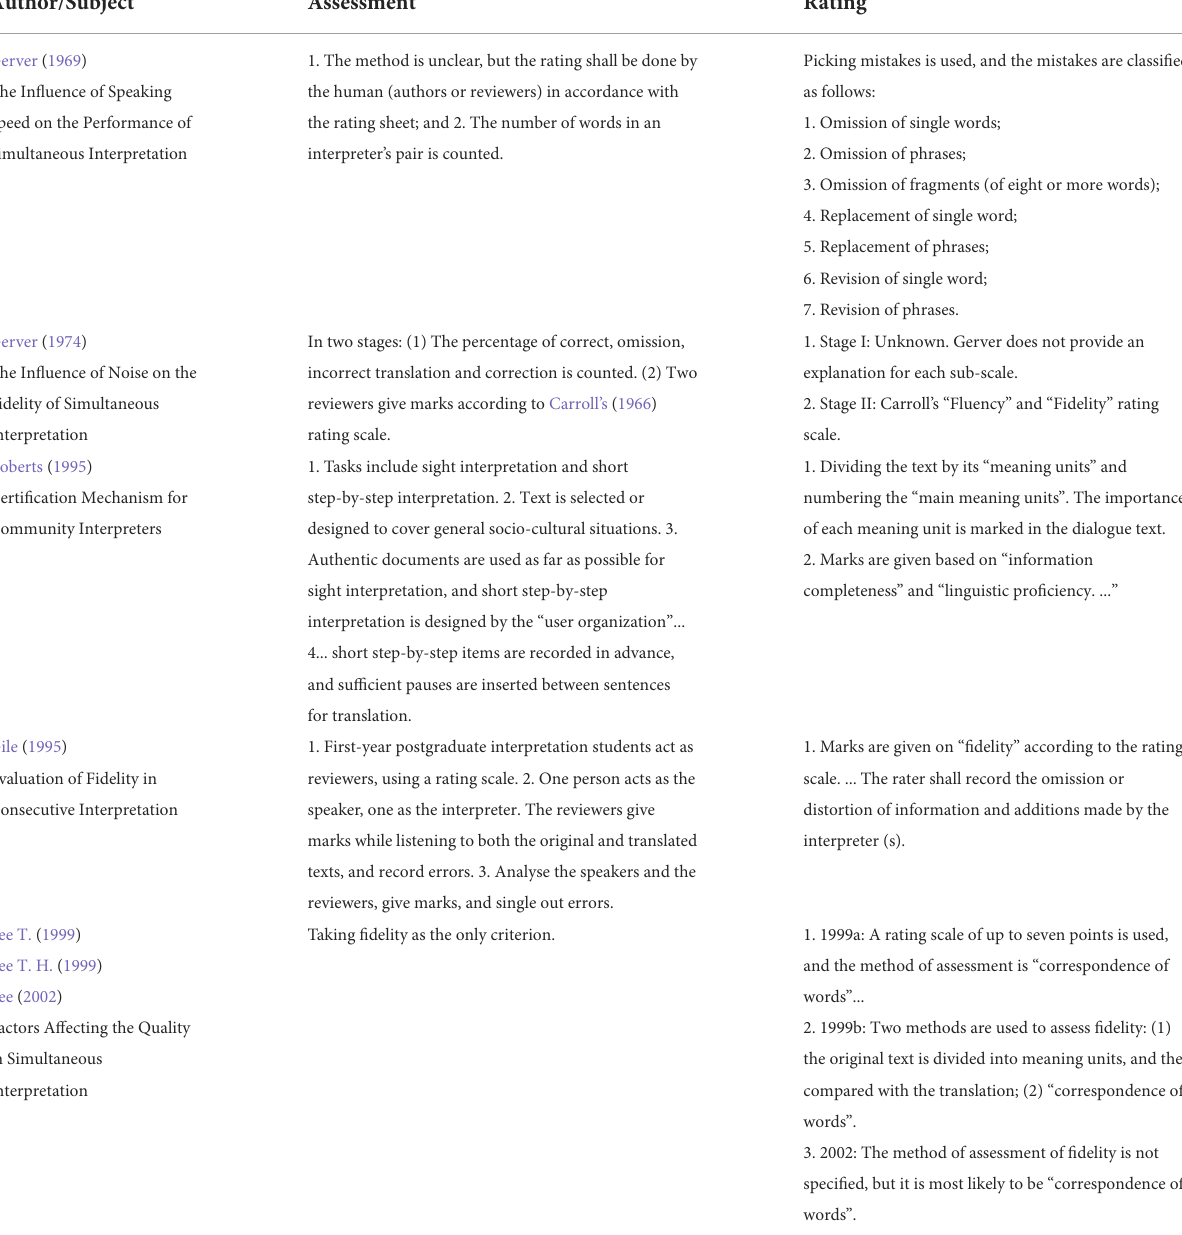
TABLE 1 Main studies on interpretation assessment before 2006 [excerpt from: Yeh and Liu